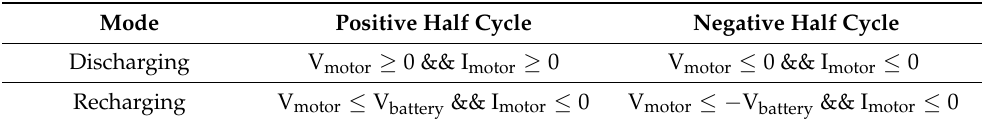
Table 2. Logic for the switching of the battery bridge.